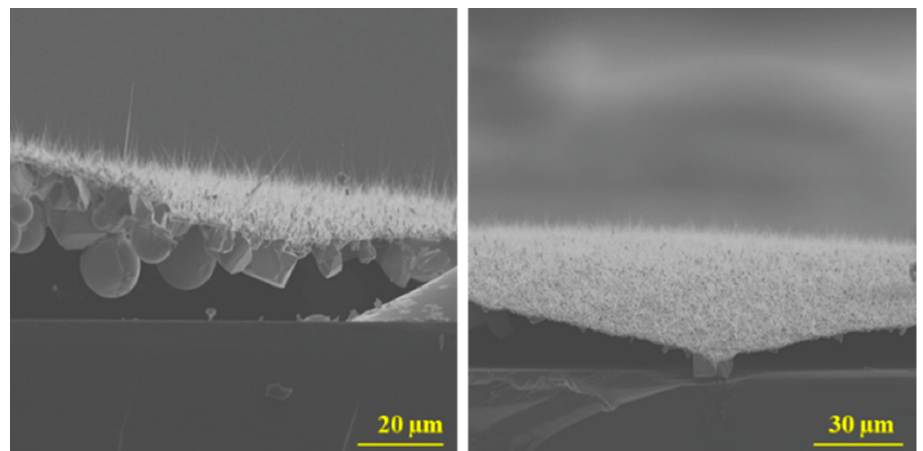
Figure 9. Cross-section SEM images of Ga 2 O 3 nanostructures on quartz by thermal oxidation of liquid Ga and Ag catalyst at 1000 °C. The cross-section images show the detachment of the Ga 2 O 3 nanowires layer from the quartz substrate and liquid drops of Ga underneath the film of Ga 2 O 3 . The length of the Ga 2 O 3 nanowires was in the range of 10–30µm.